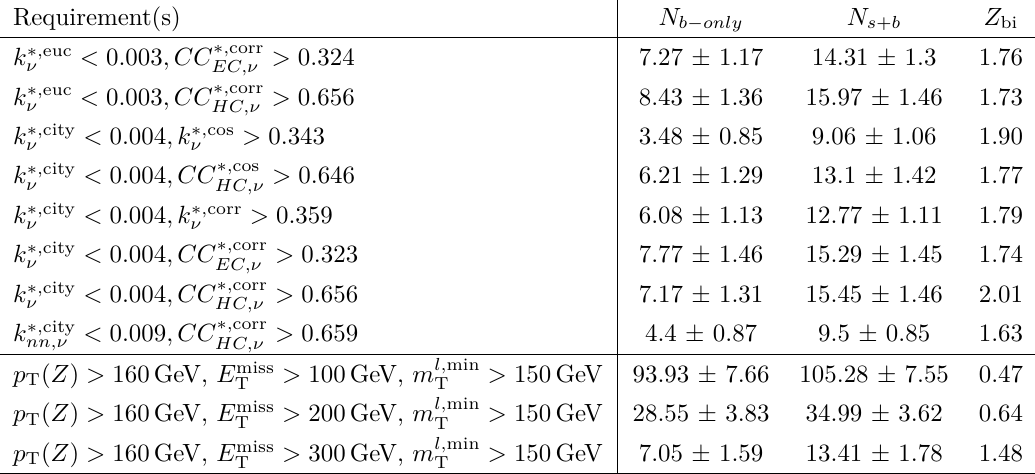
Table 3. Yields in our electroweakino search regions for our mock LHC data set ( N b − only ) and our mock MC set ( N s + b ). Also shown is the sensitivity of search regions using only the original kinematic variables. The errors quoted are statistical only, whilst the Z bi calculation uses a relative background